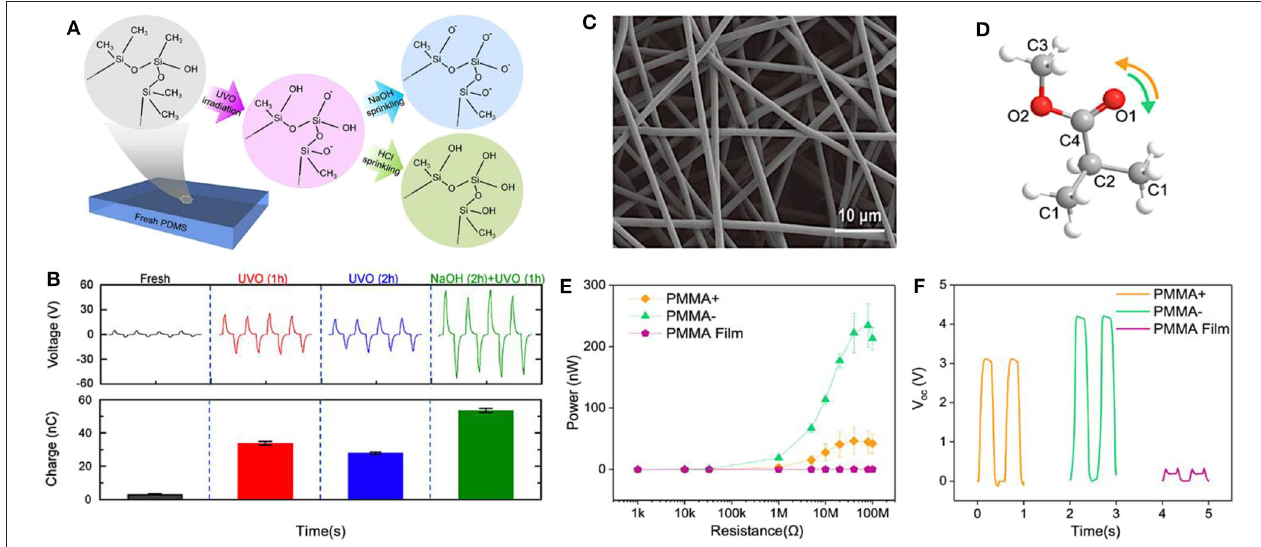
FIGURE 4 | Schematic diagrams and output performance of functionalized triboelectric materials surfaces via UVO irradiation or electrospinnig. (A) Schematic diagram about suggested mechanism of chemical elements and bonds of PDMS surface after UVO irradiation and NaOH treatment. (B) Comparison of the open-circuit voltage and induced triboelectric surface charge of surface-treated TENGs based on fresh PDMS, UVO-irradiated PDMS for 1h [UVO (1h)] and 2h [UVO (2h)], and NaOH-treated PDMS for 2h after UVO irradiation for 1h [NaOH (2h) + UVO (1h)]. Reprinted with permission from Yun et al. (2015). Copyright 2015 Elsevier. (C) SEM image of electrospun PMMA fibers. (D) Schematic structure of a single unit of PMMA polymer chain. (E) Output power and (F) open-circuit voltage of electrospun PMMA-based TENGs. Reprinted with permission from Busolo et al. (2018). Copyright 2018